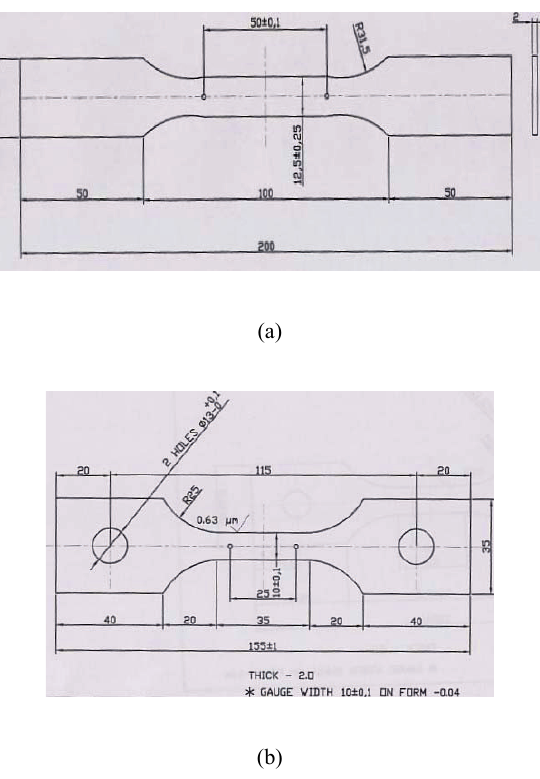
Figure 3. Schematic diagram of tensile test specimen, a. Room temperature tensile test specimen, b. High Tempera- ture tensile specimen.